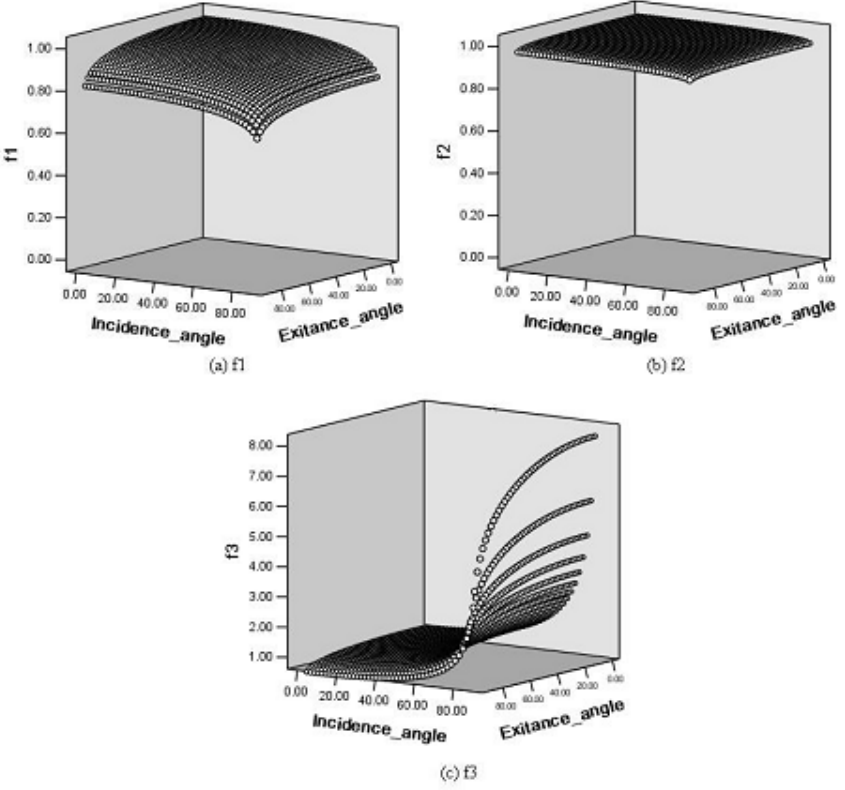
Figure 5. The distributions of values of f 1, f 2, and f